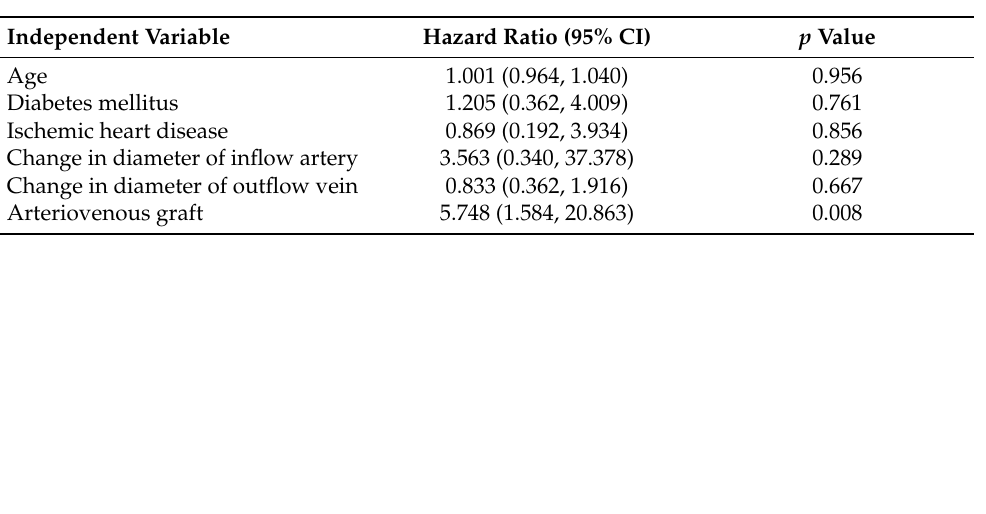
Table 5. Univariate Cox proportional hazard regression analysis to predict the risk of the occurrence of complete occlusive access thrombosis at a specific